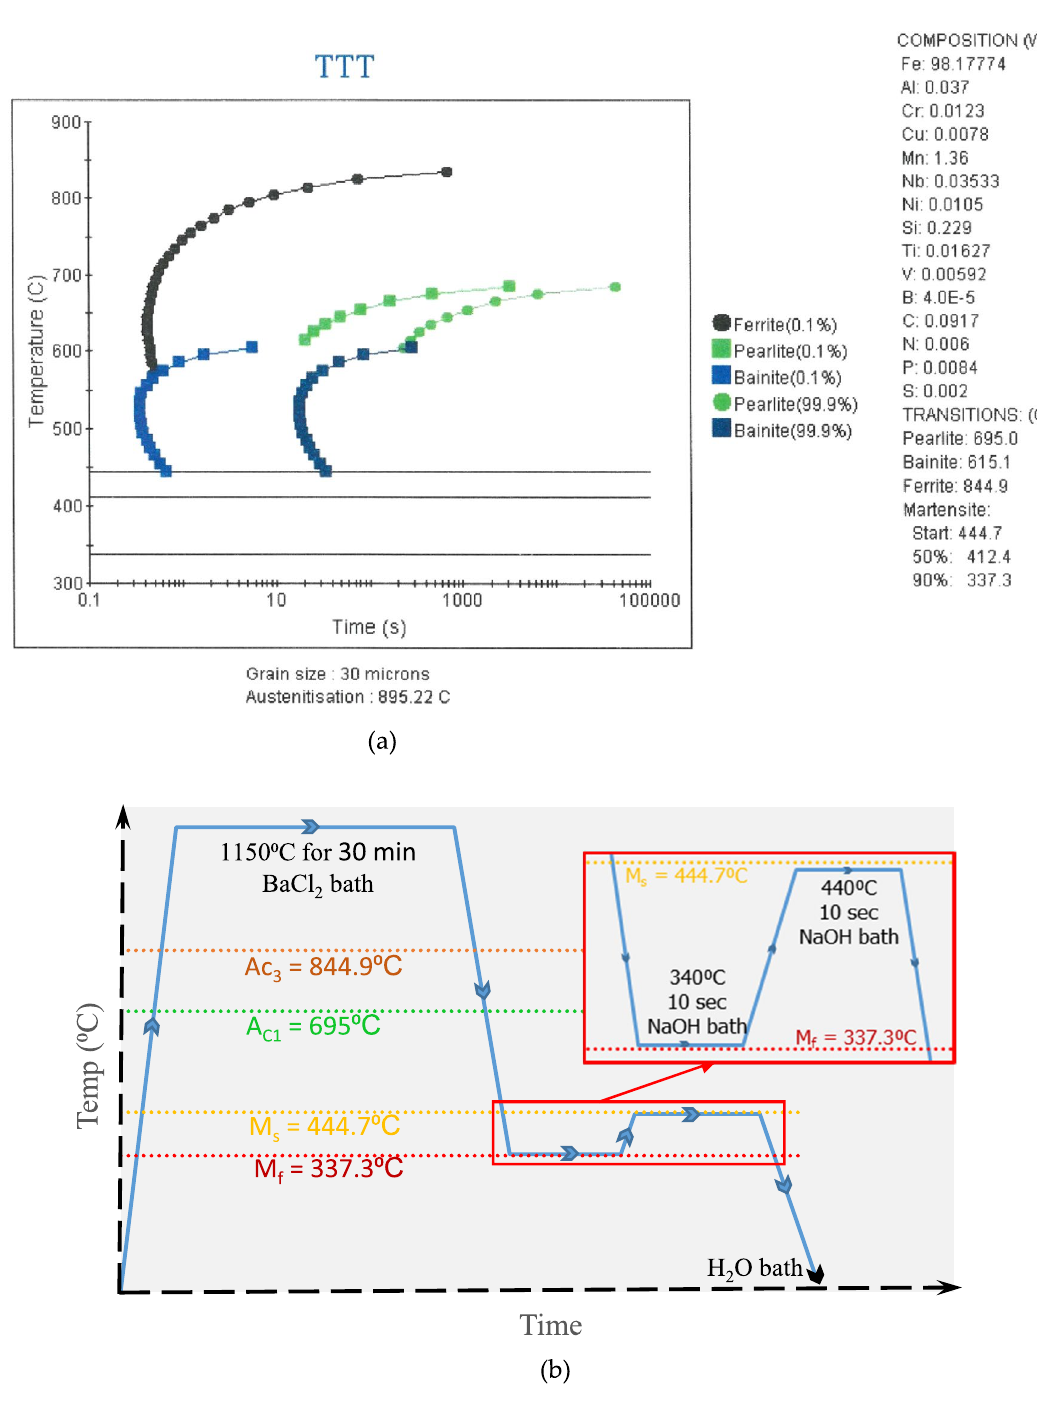
Figure 1. ( a ) Time–Temperature-Transformation diagram for the microalloyed steel, and ( b ) the quenching and partitioning heat-treatment cycle used in this